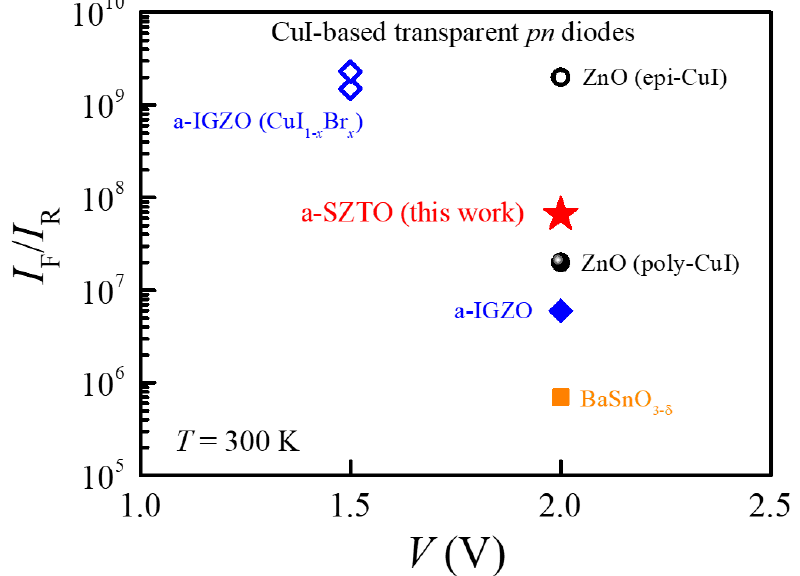
Figure 4. Summary of current rectification ratios I F / I R of various heterojunction diodes consisting of the p -CuI film. The color indicates different n -type films for the pn diodes, and here only the cases of a high I F / I R > ≈ 10 5 are provided. I F / I R of the CuI/SZTO diode is estimated by the fitted I F at +2 V and I R at − 2 V in this work. I F / I R of the CuI 1- x Br x /IGZO diode is estimated by the measured I F at +1.5 V and the fitted reverse saturation current [10]. I F / I R of CuI/ZnO [2,11], CuI/a-IGZO [3], and CuI/BaSnO 3- δ [12] diodes are obtained from the measured current at ± 2 V.